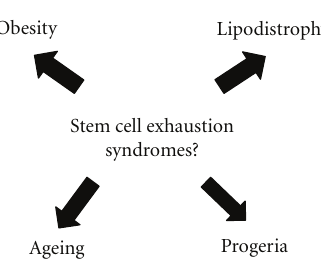
Figure 5: Pathologies propably caused by a stem cell exhaustion